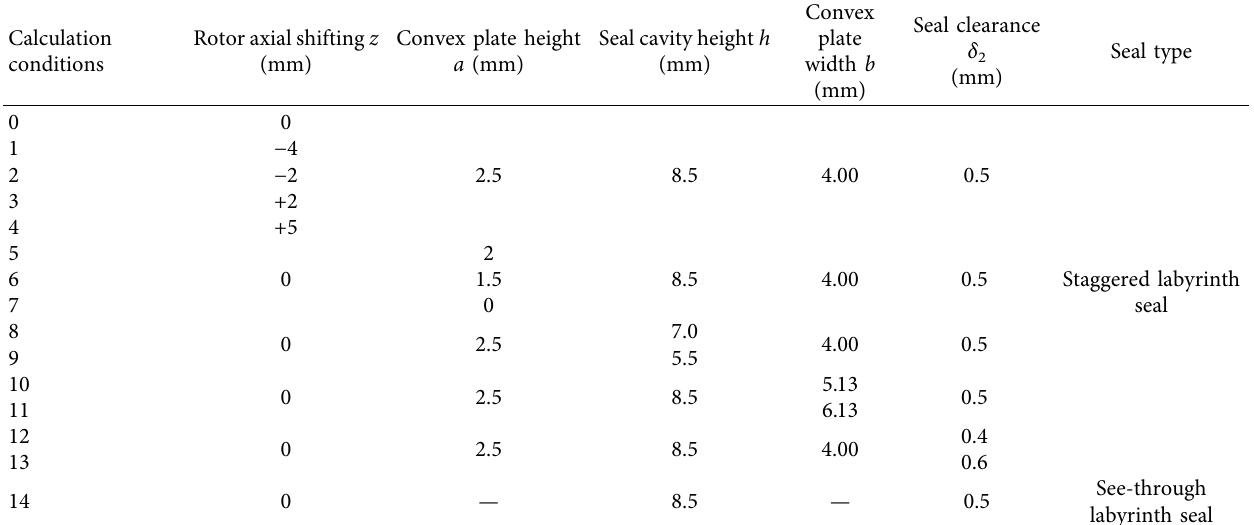
Table 2: Calculation conditions and